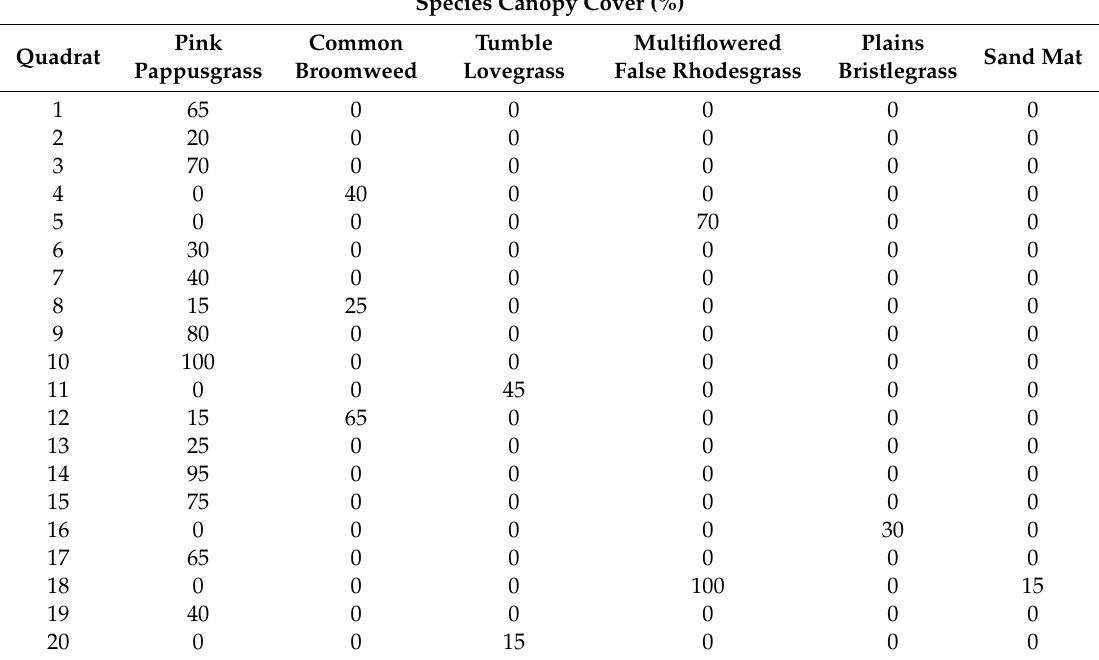
Table 1. Individual species canopy cover for the 20 quadrat frames (area = 0.25 m 2 ) to represent the range of forage mass.